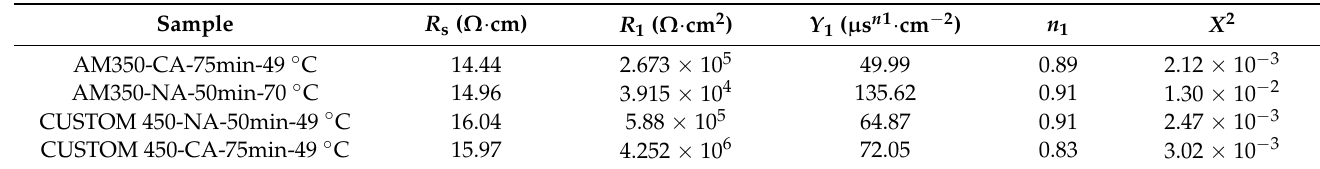
Table 7. EIS parameters obtained by EEC simulation of CUSTOM 450 and AM 350 passivated stain- less steels immersed to 1 wt. % H 2 SO 4 solution.